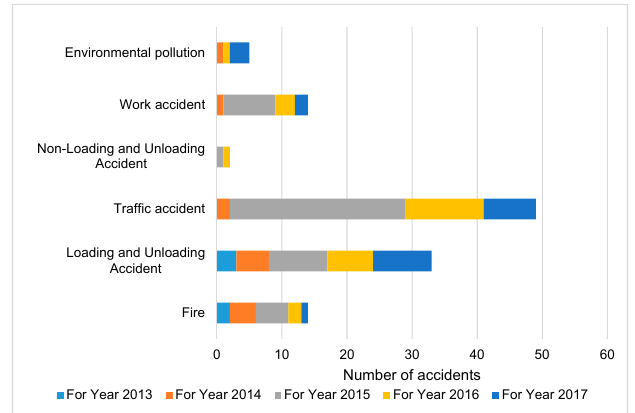
Figure 1. Accident Data in the Container Terminal During Five Years as Case Study. Table 3. Common causes of accidents and the percentage of their contribution.